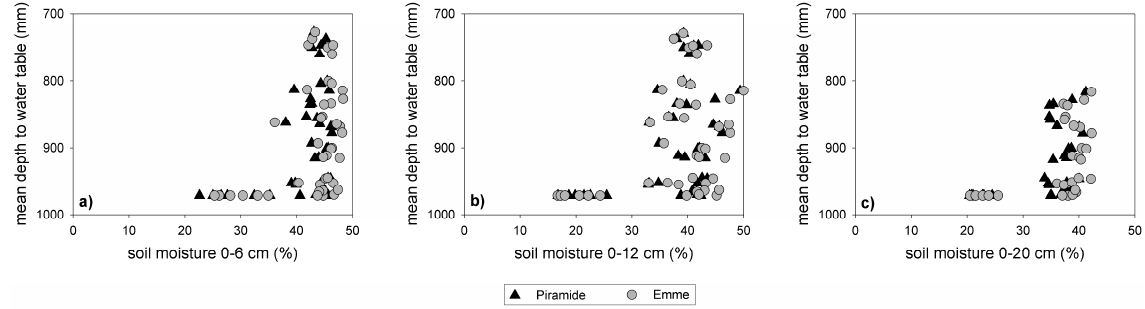
Figure 5. Threshold behaviour in the relationship between average soil moisture and streamflow (a) and between soil moisture and hillslope- 666